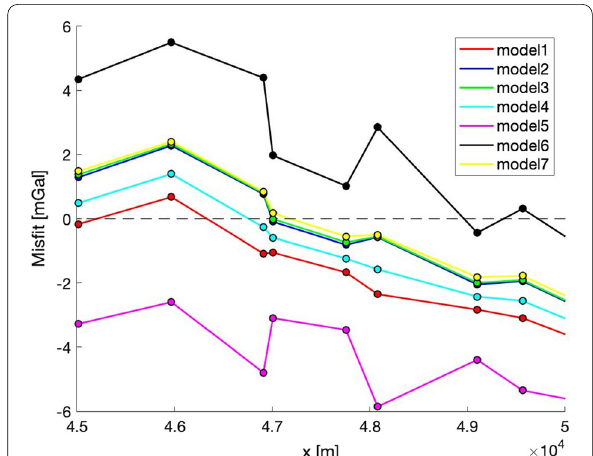
Fig. 11 Point-wise misfit for the surface gravity values, with a focus on the 45 to 50 km section along the model line within the same geological unit. Models 5 (low density) and 6 (high density) present short-wavelengths symmetric steps, which strongly correlate with the position of two pairs of surface gravity points at 47 and at 48 km distance acquired at significantly different elevations. These misfit steps do not appear or are smaller for the other density models, which means that measurements taken at different elevations have the potential to constrain local densities. The point-wise misfit represented in the figure is defined as synthetic minus observed gravity